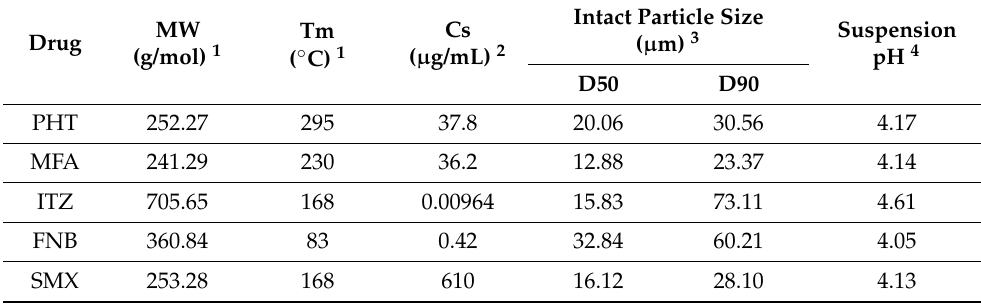
Table 1. The physicochemical properties of poorly water-soluble